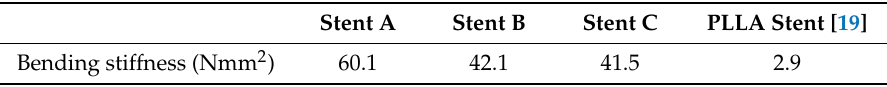
Table 1. Bending stiffness values of the three magnesium alloy stents and a bioresorbable poly(L-lactide) (PLLA) stent at a deflection of 0.6